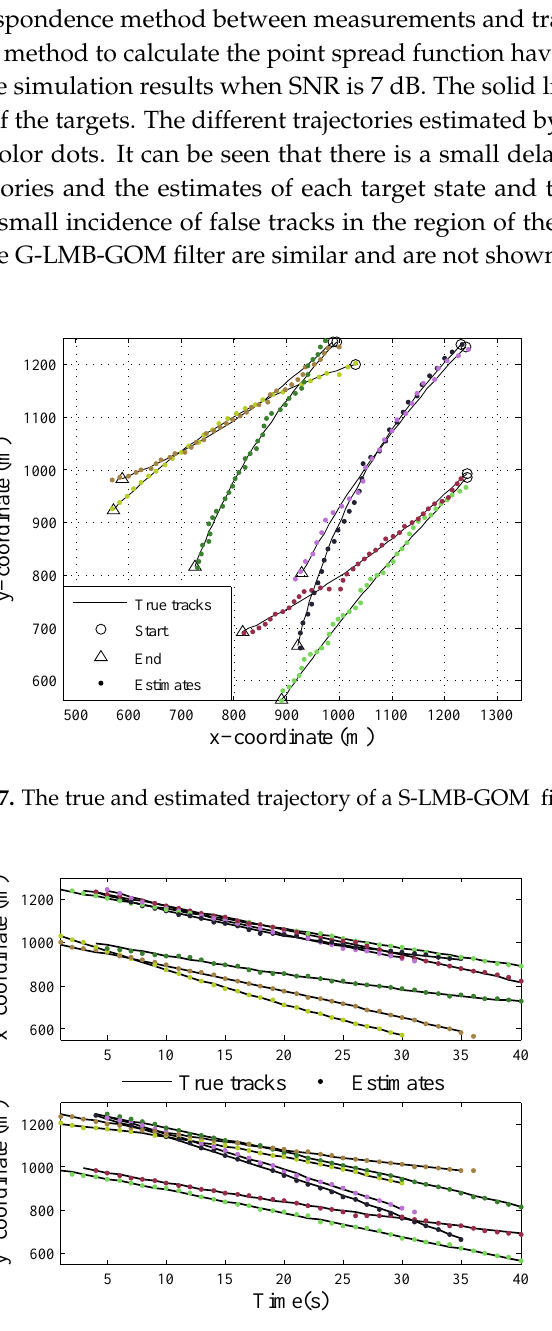
Figure 8. The true and estimated trajectory of S-LMB-GOM filter in x and y